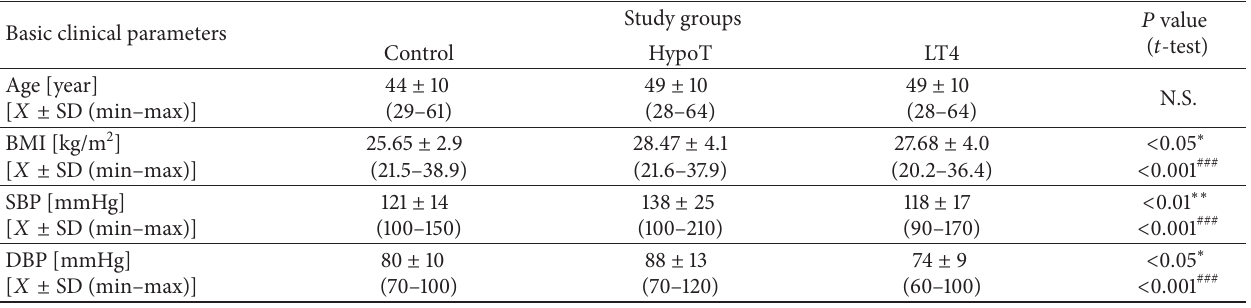
Table 1: Basic clinical parameters in control and hypothyroid patients before (HypoT) and after treatment with LT4 (LT4). Basic clinical parameters